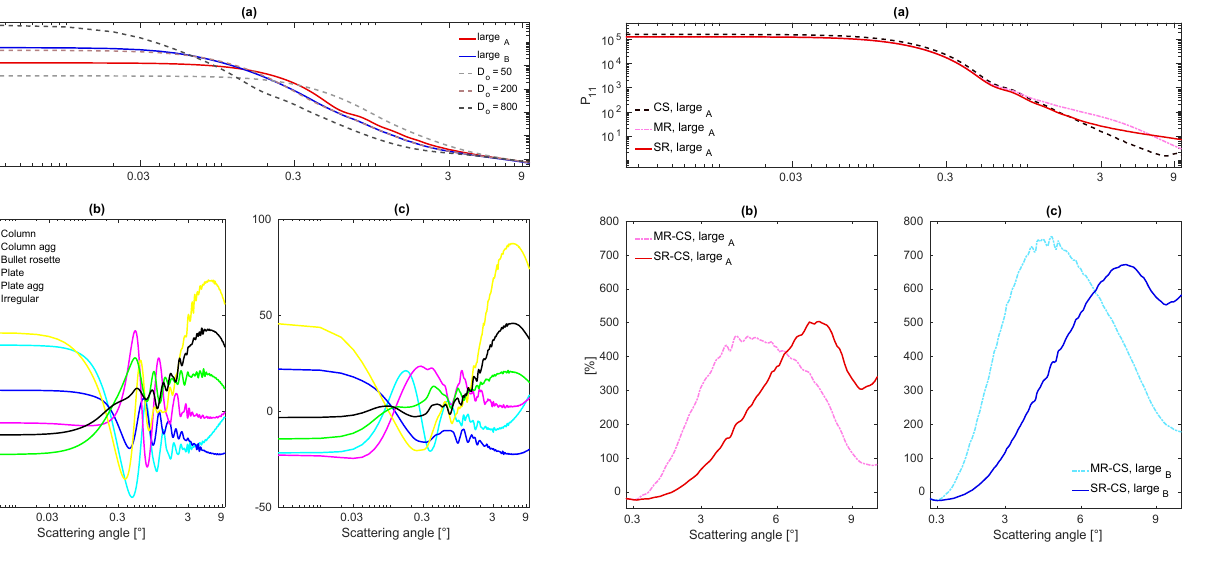
Figure 5. Sensitivity of the vertically integrated phase functions to the roughness of large ice crystals. (a) The P 11 of the in situ-based size-shape distribution of smooth, moderately, and severely rough ice crystals of flight A (large A ). (b, c) The relative differences in P 11 between MR and CS ice crystals and between SR and CS ice crystals of flight A and